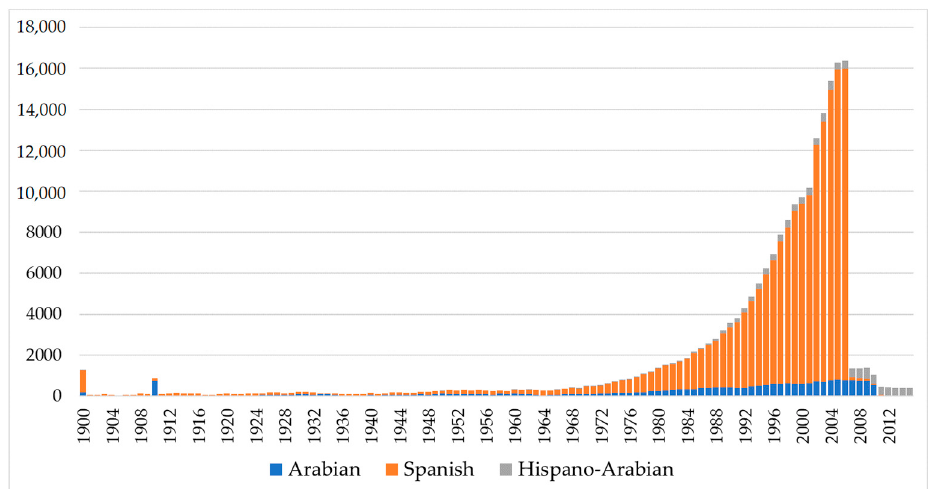
Figure 1. Historical birth number evolution in Hispano-Arabian (Há), Spanish (PRE) and Arabian (PRá) Purebred Horses from 1900 to 2019.